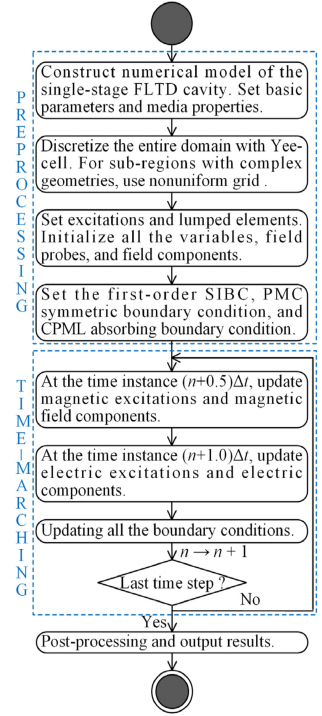
Figure 11. Flow chart of numerical calculations based on the field-circuit coupled time-domain finite integration theory